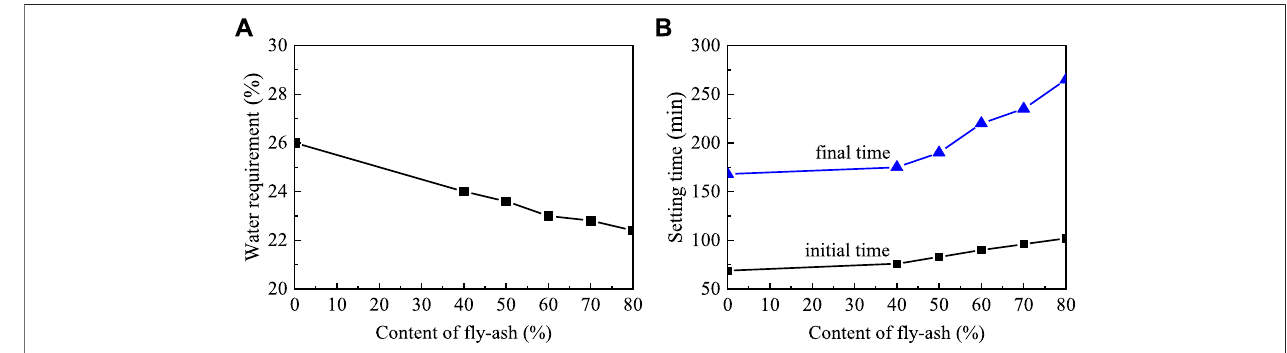
FIGURE 1 | Test results of cement fl y-ash paste: (A) water requirement of normal consistency; (B) setting time.